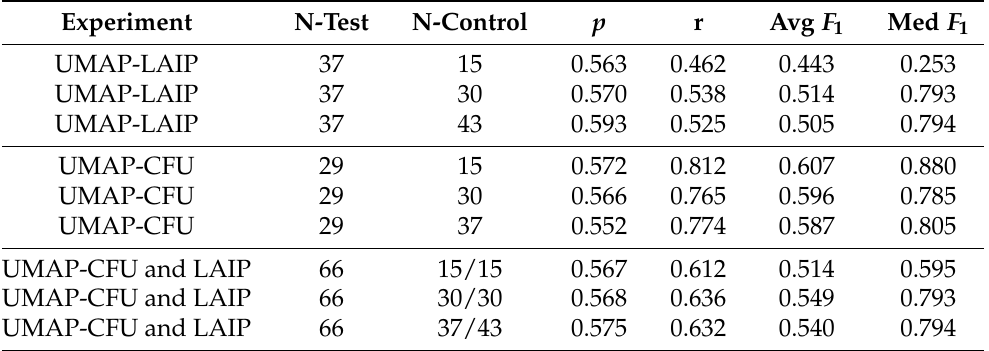
Table 4. Results of the proposed classification pipeline for varying number of control